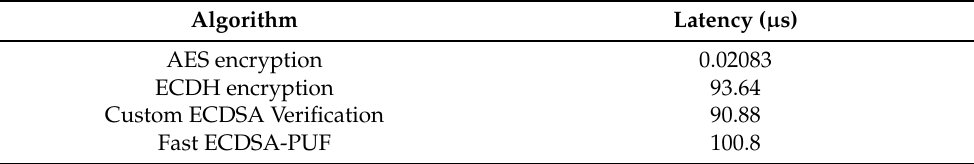
Table 2. Image encryption subsystem speed results under ASIC implementation.